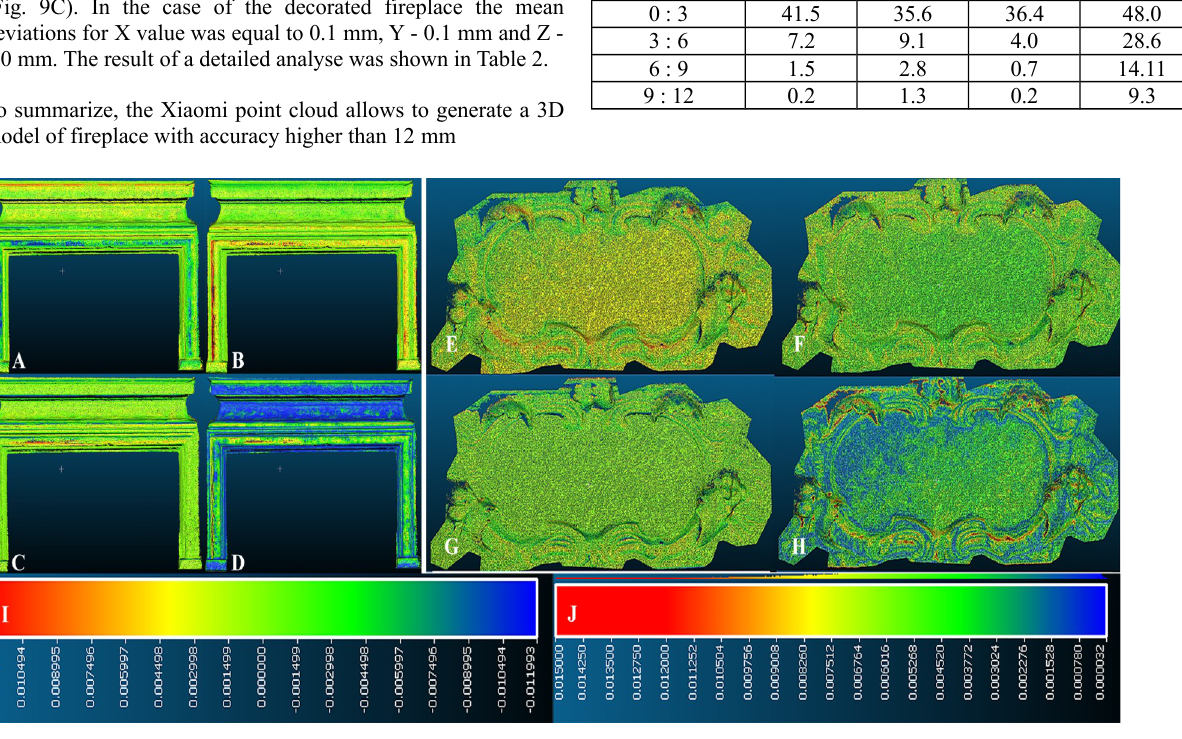
Figure 9. Deviations between point cloud form TLS and Xiaomi 4K camera for fireplace: A) X value, B) Y value, C) Z value and D) linear vale and decorative stucco frame: E) X value, F) Y value, G) Z value and H) linear vale. Scale bars for X, Y, Z values (I) and linear deviations (J)